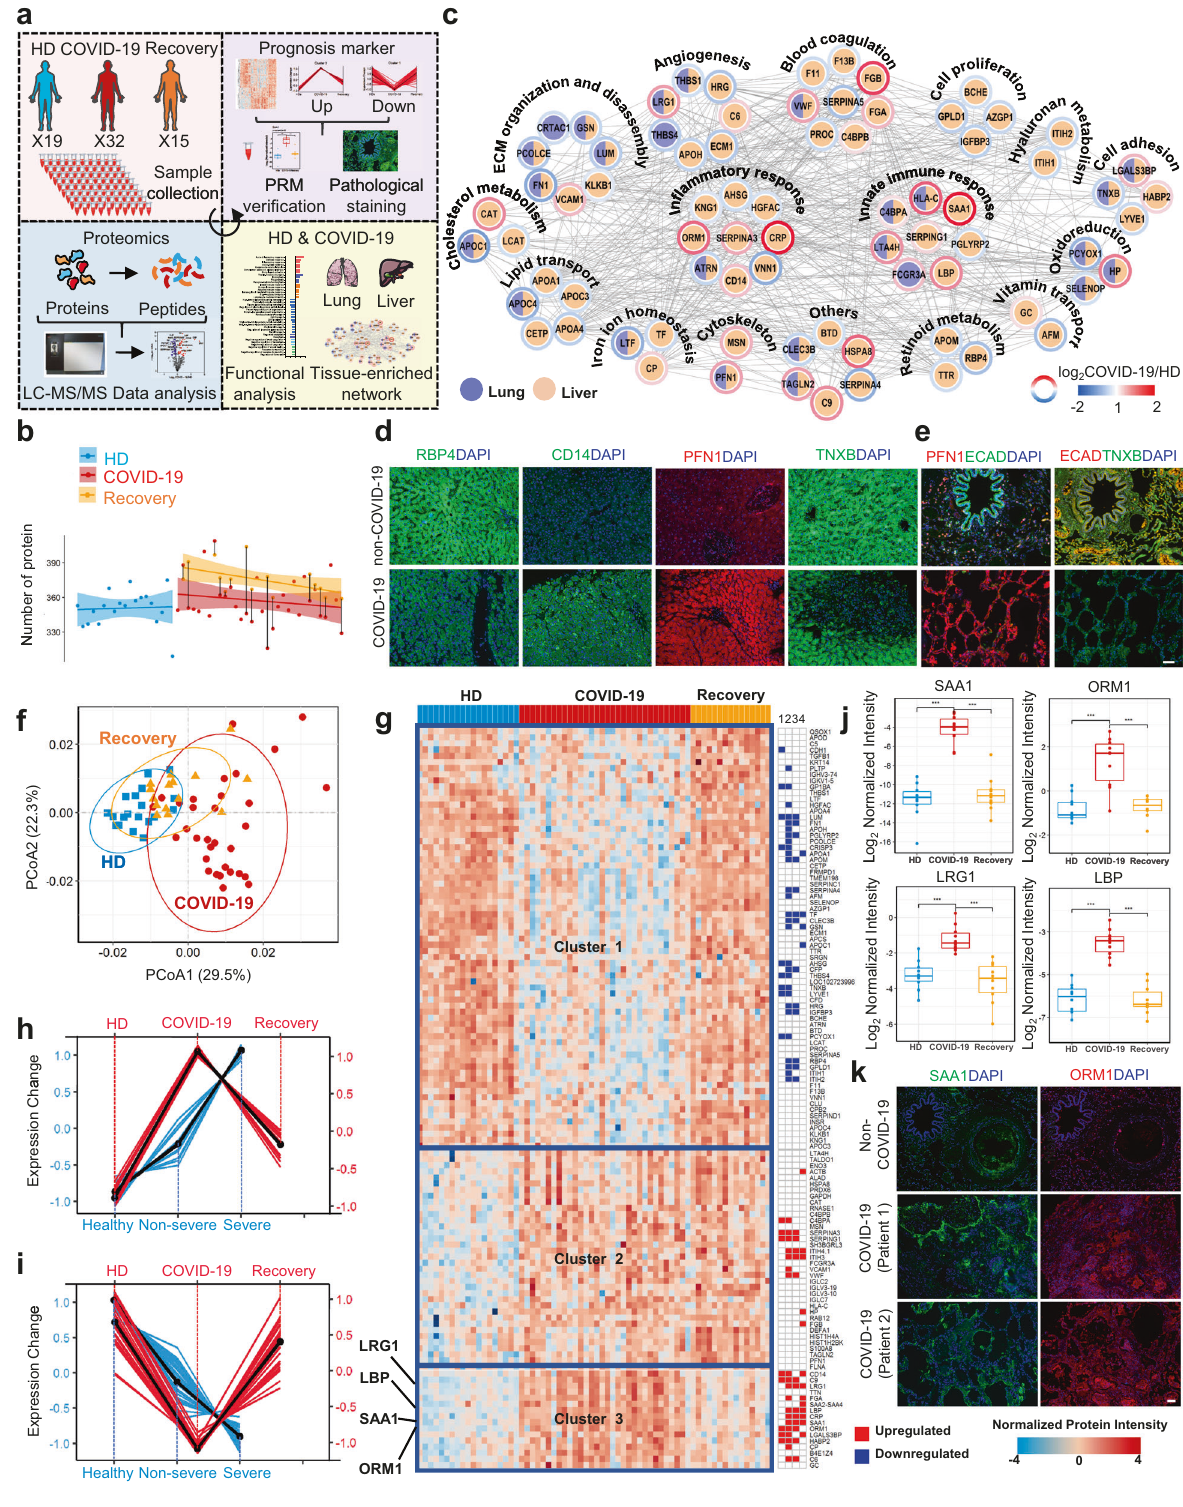
were restored to the corresponding levels in HDs after disease recovery (Fig. 1j and Supplementary Fig. S7a), which further highlighted their values as prognostic biomarkers. Besides, the expression of three of these markers (SAA1, ORM1, and FGA)